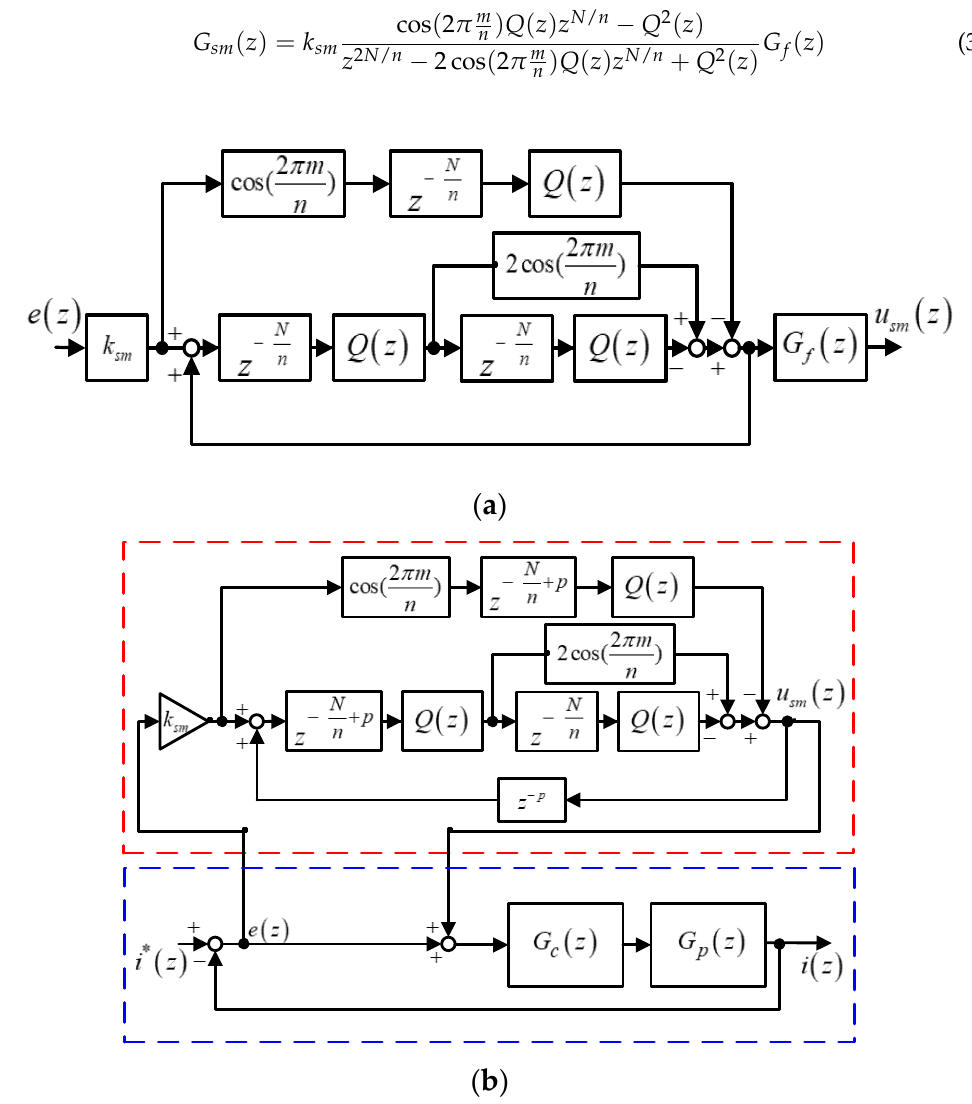
Figure 8. The block diagram of selective harmonic control: ( a ) selective harmonic generator; ( b ) block diagram.